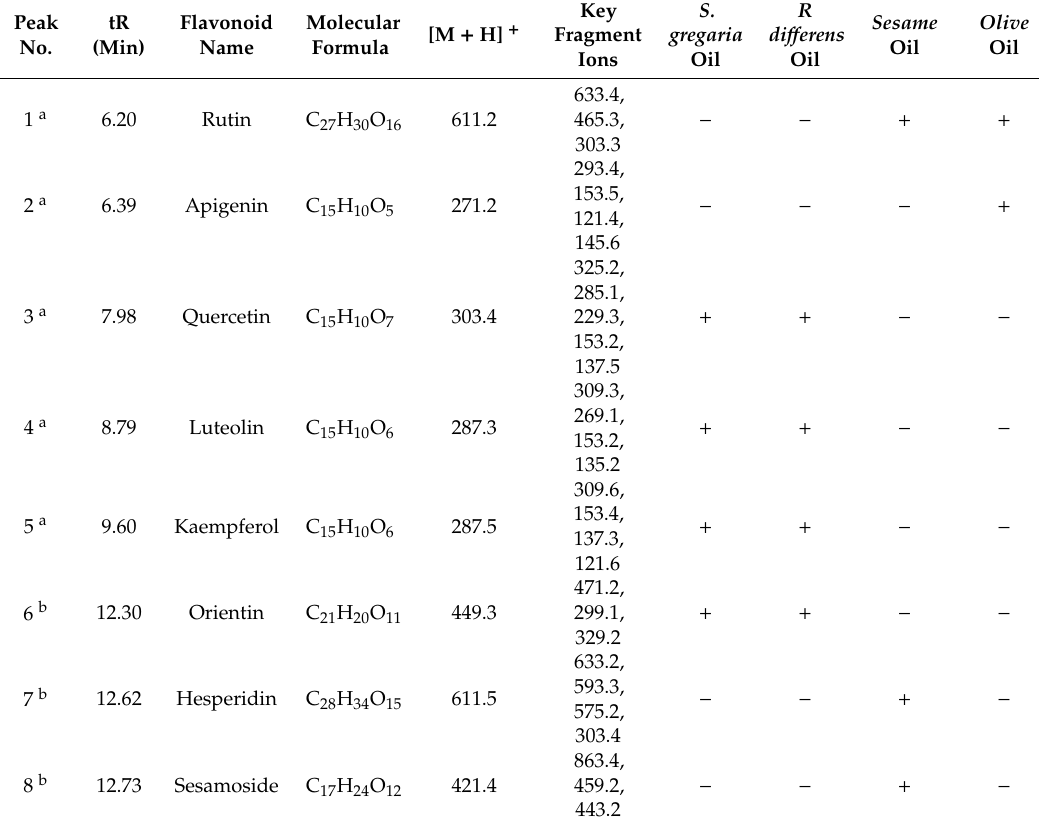
Table 2. Identified flavonoids in analyzed oils.